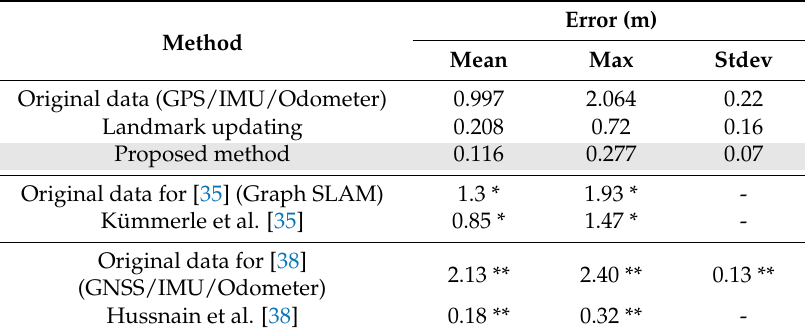
Table 7. Overall performance comparison.